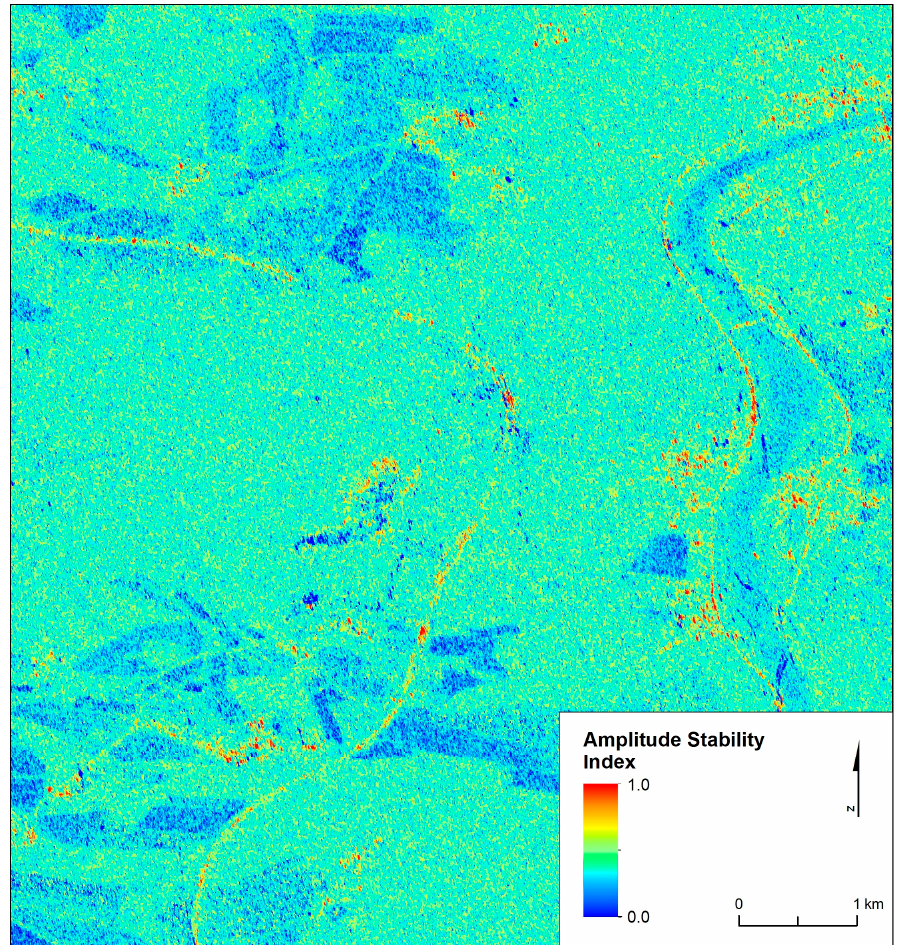
Figure 6. An example of Amplitude Stability Index (ASI) in the area of interest, time series